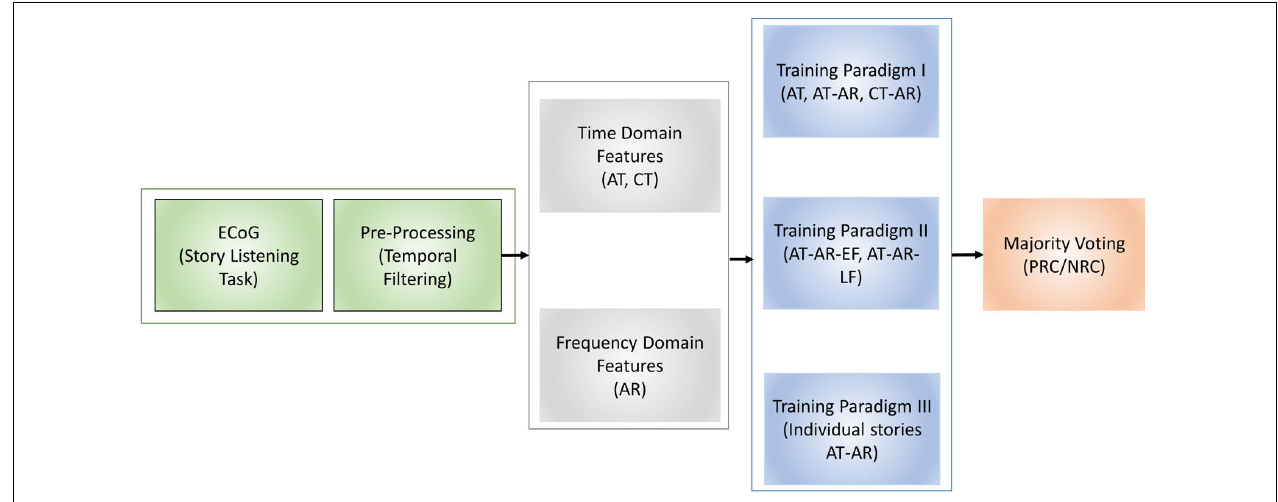
FIGURE 2 | A overview of the steps involved in the proposed methodology showing ECoG data recording in response to story listening task, time and frequency domain feature extraction, different training paradigms and majority voting to classify positive and negative response channels. AT, Active Time; AR, Auto Regressive; CT, Control Task; EF, Early Fusion; LF, Late Fusion; PRC, Positive Response Channel; NRC, Negative Response